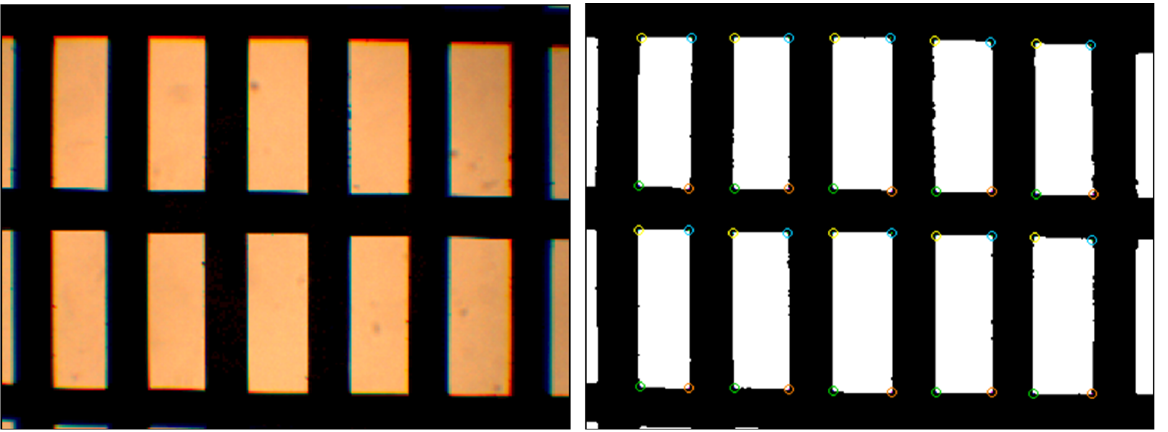
Figure 3. Microscopic image ( left ); same image analyzed by Euclides v.1.4 ( right ).